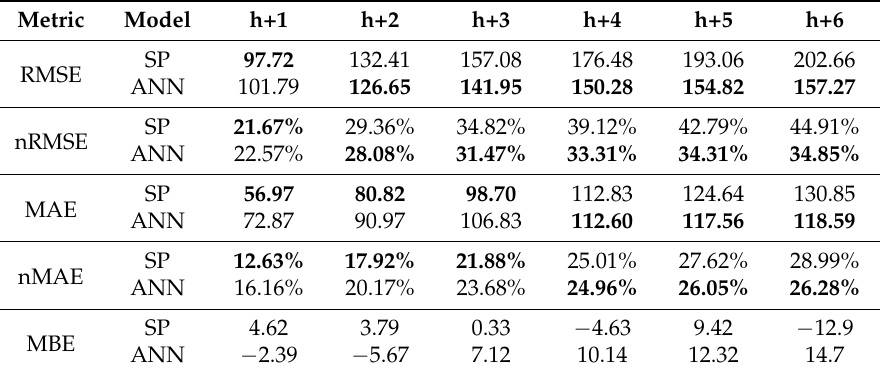
Table 6. Performance metrics (in Wh/m 2 for RMSE, MAE, and MBE) for GHI (in bold the best predictor for each horizon and each error metric) (Odeillo site).